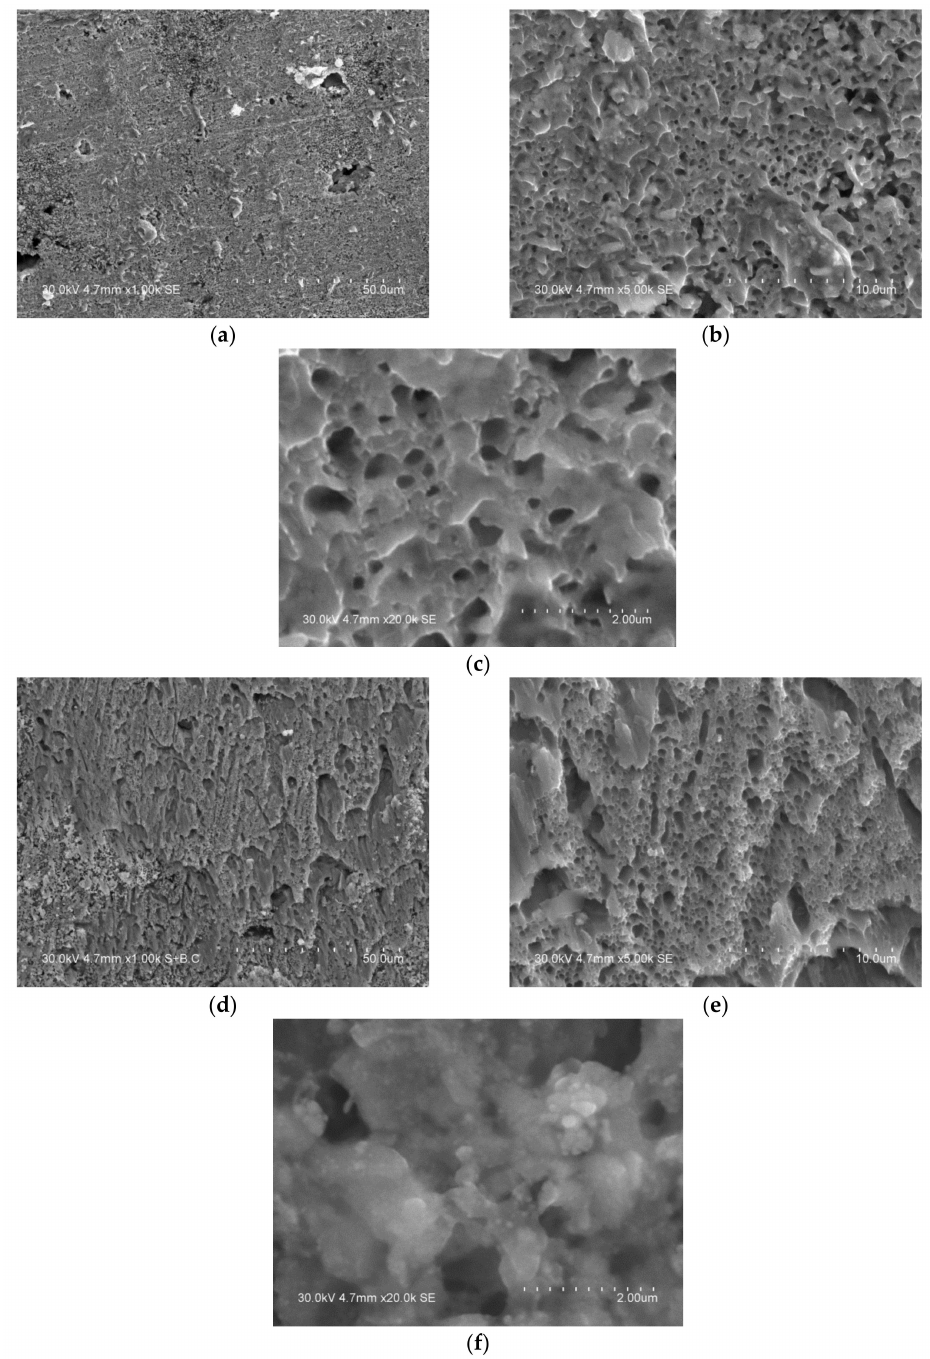
Figure 3. Fracture surface of the in situ formed silver brazing layers: ( a – c ) die-assisted configuration, ( d – f ) joining without a die (SEM images). The micrographs were taken with different magnifications to show ( a , d ) general view, ( b , e ) porous structure, ( c , f ) silver